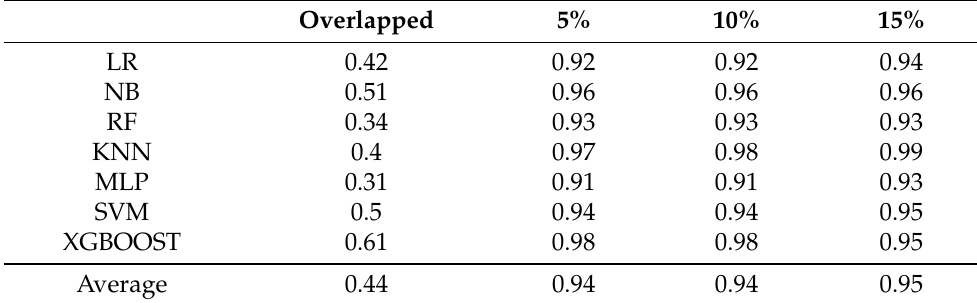
Table 1. Performance comparison of classifiers in terms of